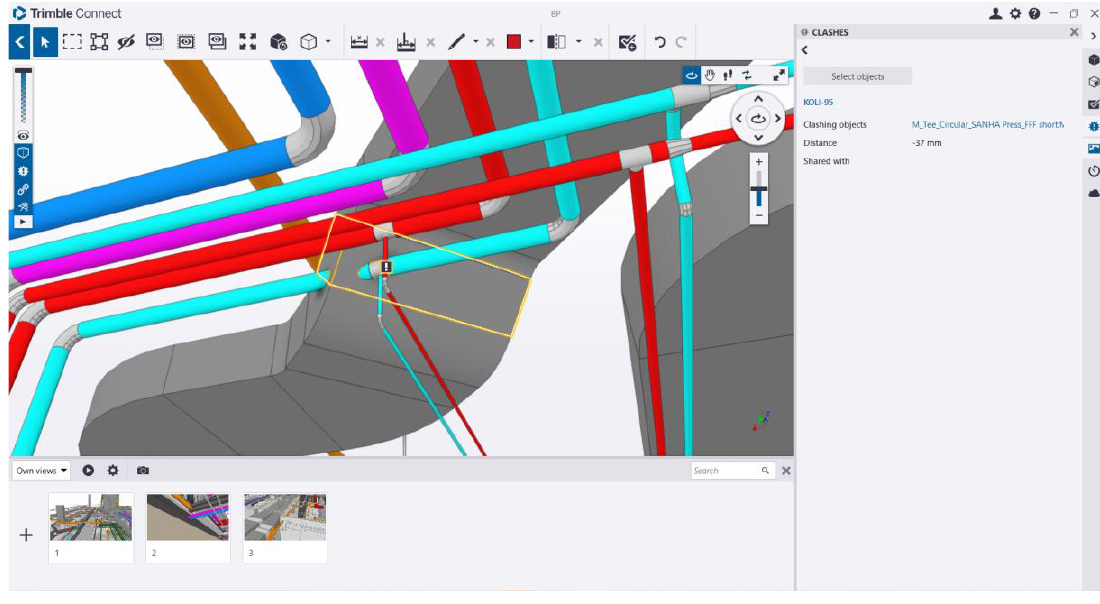
Figure 3: Example of the MEP clash, [authors]